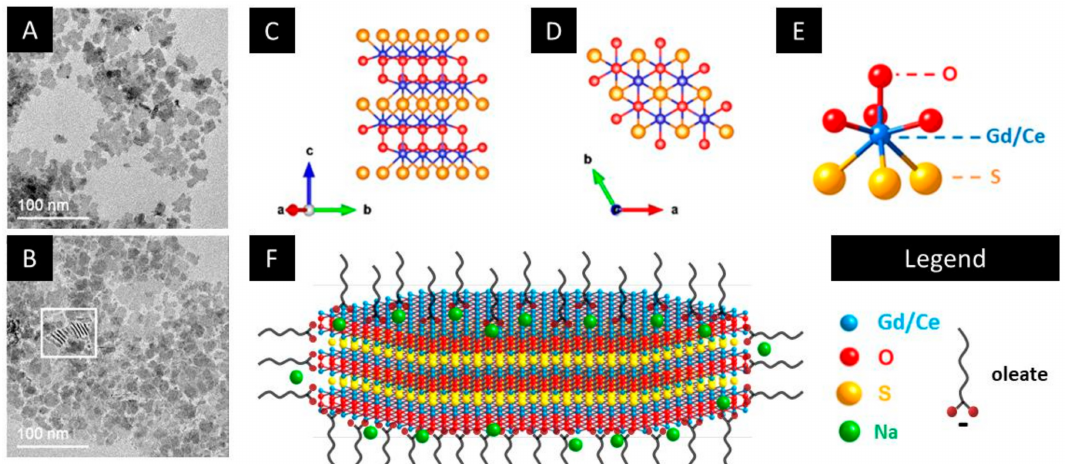
Figure 1. Transmission electron microscopy of Gd 2 O 2 S ( A ) and GdCeO 2 S ( B ) nanoparticles. In ( B ), the white square indicates nanoparticles that are staked and observed sideways. ( C ) Representation of the lamellar cristallographic structure of Gd 2 O 2 S. ( D ) View from the (001) direction of the structure. ( E ) Environment of Gd/Ce in the structure. ( F ) Schematic representation of [Ln 2 O 2 ] 2+ -terminated Gd 2(1 − x ) Ce 2 x O 2 S nanoparticles covered with oleate